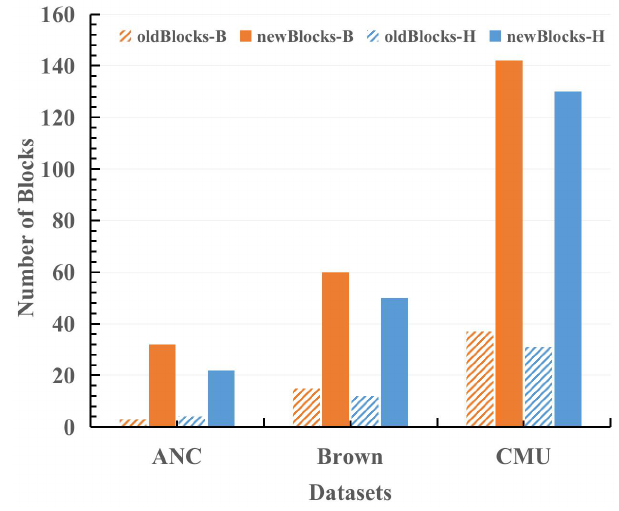
Figure 10. The number of blocks involved in updating 50,000 words (256 kB).